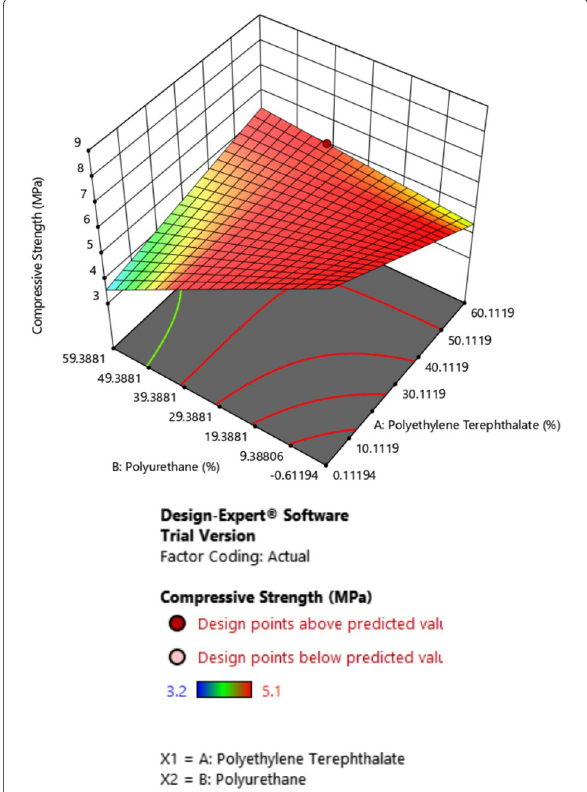
Fig. 6 3D surface plot (compressive strength)